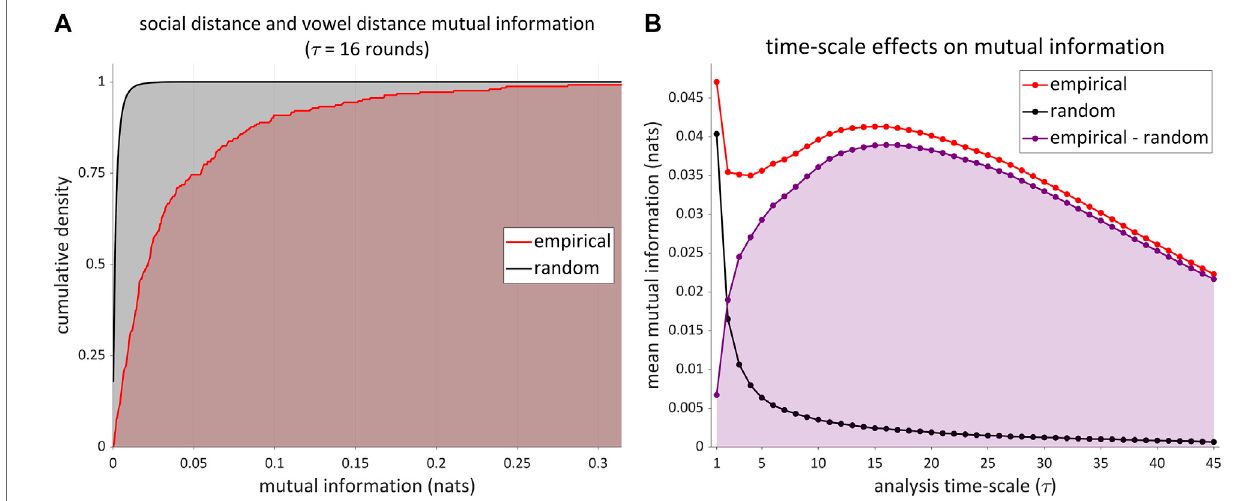
FIGURE9| Mutualinformationbetweensocialdistanceandvoweldistancetimeseries. (A) Cumulativedensityofestimatesofmutualinformationonatimescaleof τ = 16 rounds (red line: empirical; black line: obtained from random permutation). (B) Mean mutual information as a function of analysis timescale, along with the difference between values associated with empirical and randomly permuted data (purple).